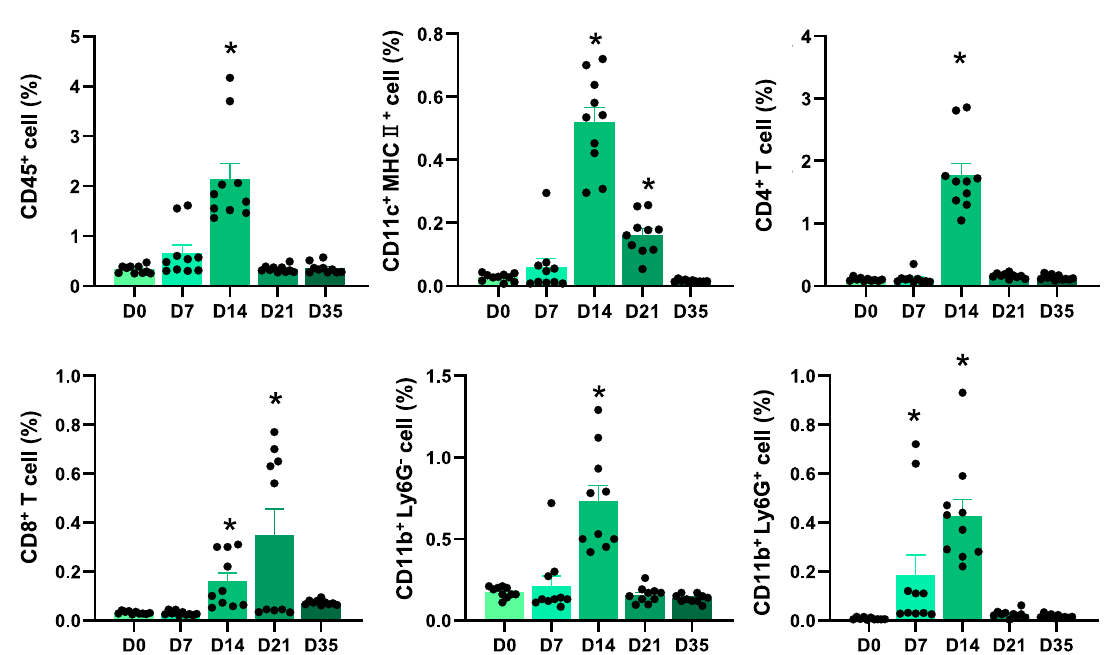
Figure 1. Dynamics of inflammatory cells in cardiac myosin peptide-induced autoimmune myocarditis. Quantification of inflammatory cells in the hearts obtained from mice with experimental autoimmune myocarditis, represented as a percentage of live cells at the indicated time points (n = 10 at each time point). The values are expressed as the mean ± standard error of the mean. * P < 0.05 vs. day 0.